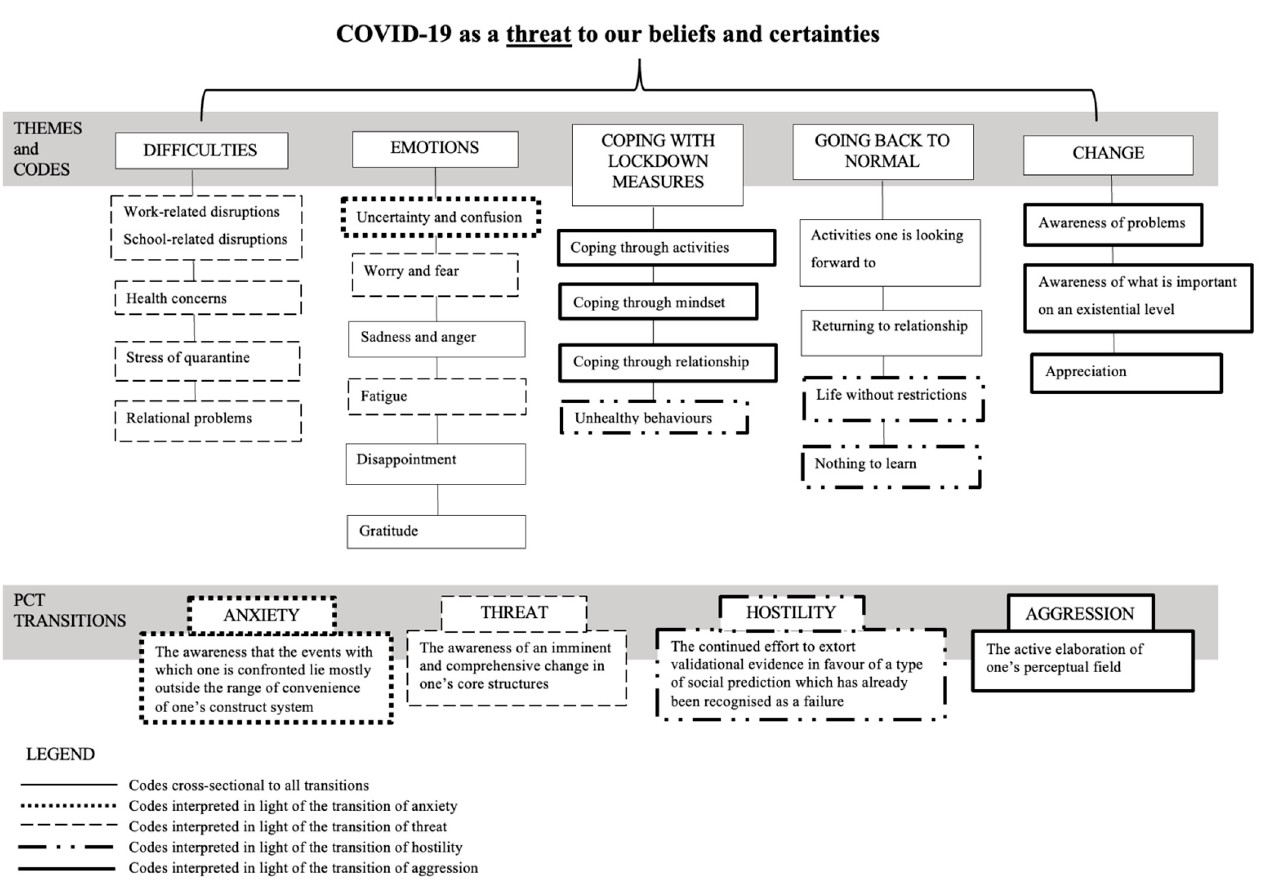
Figure 1. Map of themes and codes together with the PCT transitions and combinations of codes.